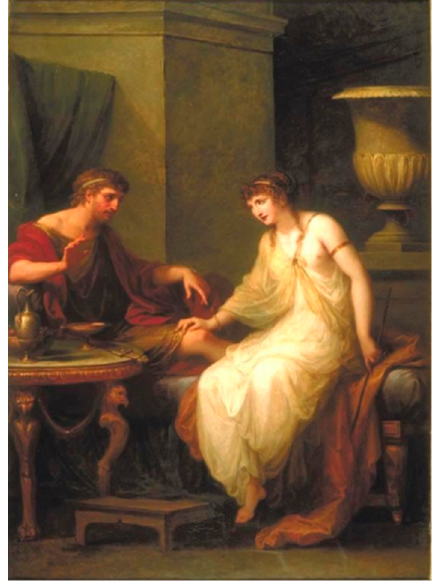
Figure 5. Odysseus and Circe: Angelica Kauffman, 1786. At what point might concerns and angst be disregarded to take advantage of what is offered, notwithstanding fear of the consequences?